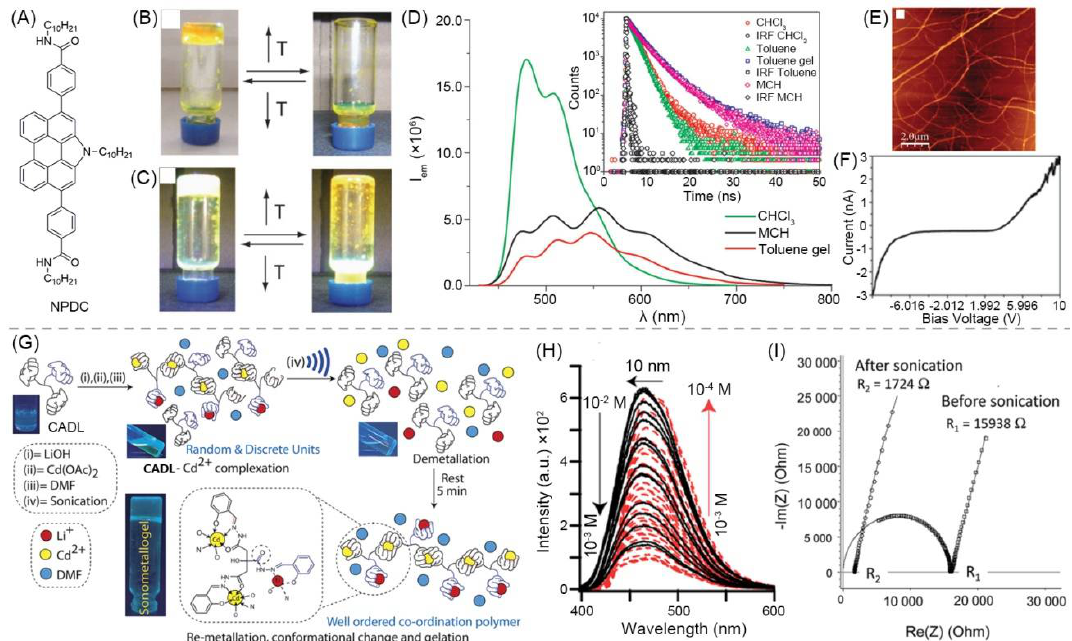
Figure 2. ( A ) Chemical structure of NPDC. Photographs of gel-to-sol transition of NPSC-based organogel without ( B ) and with ( C ) 360 nm UV illumination. ( D ) PL spectra of NPDC under different conditions ( λ ex = 420 nm) with inset showing fluorescence lifetime-decay profiles. ( E ) AFM image of aggregations of NPDC. ( F ) CAFM image of toluene gel of NPDC onto HOPG as surface. Adapted with permission [81]; copyright 2013, Royal Society of Chemistry. ( G ) Schematics of fabrication procedure of sonometallogel from CADL and metal ions along with fluorescent photographs. ( H ) PL spectra showing dilution of sonometallogel to demonstrate presence of AIE and ACQ phenomena. ( I ) Experimental Nyquist impedance diagrams before and after sonication. Adapted with permission [82]; copyright 2017, Royal Society of Chemistry.